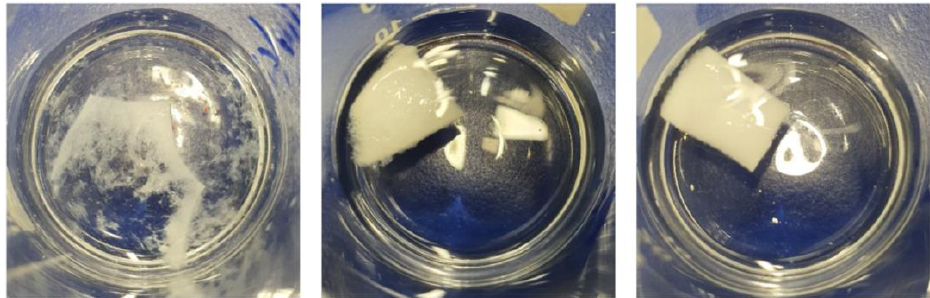
Figure 5. Porous matrices after immersion in PBS solution: PLA/PVA after 5 min ( left ), PLA/PVA- SiO 2 ( middle ) after 1 h, and PLA/PVA-CH ( right ) after 1 h.